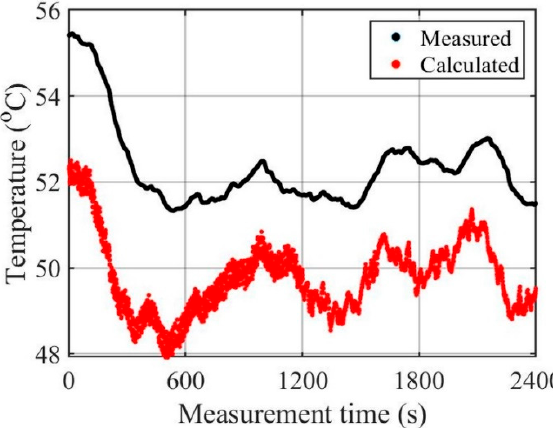
Figure 5. The operating temperature obtained from the fits to the entire I – U curves with 100 repre- sentative points jointly with the measured PV module backplate temperature during the 40 min measurement period.